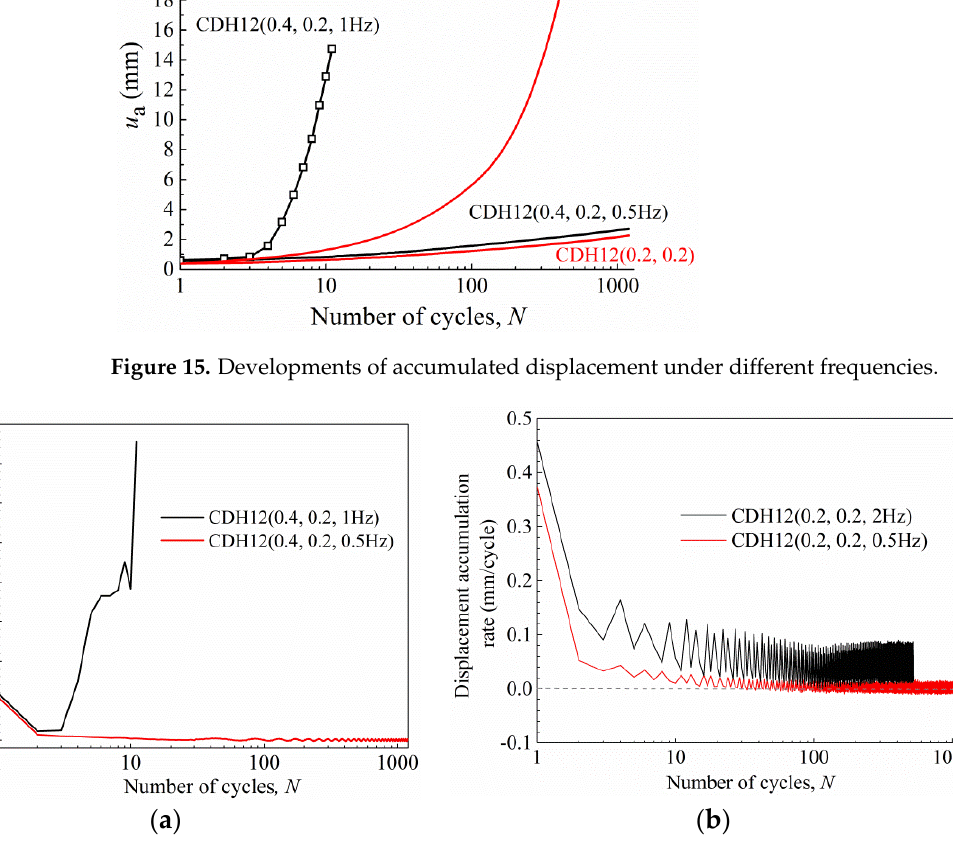
Figure 16. Developments of displacement accumulation rate under different frequencies: ( a ) Q mean / Q t = 0.4 and Q cyc / Q t = 0.2; ( b ) Q mean / Q t = 0.2 and Q cyc / Q t = 0.2.